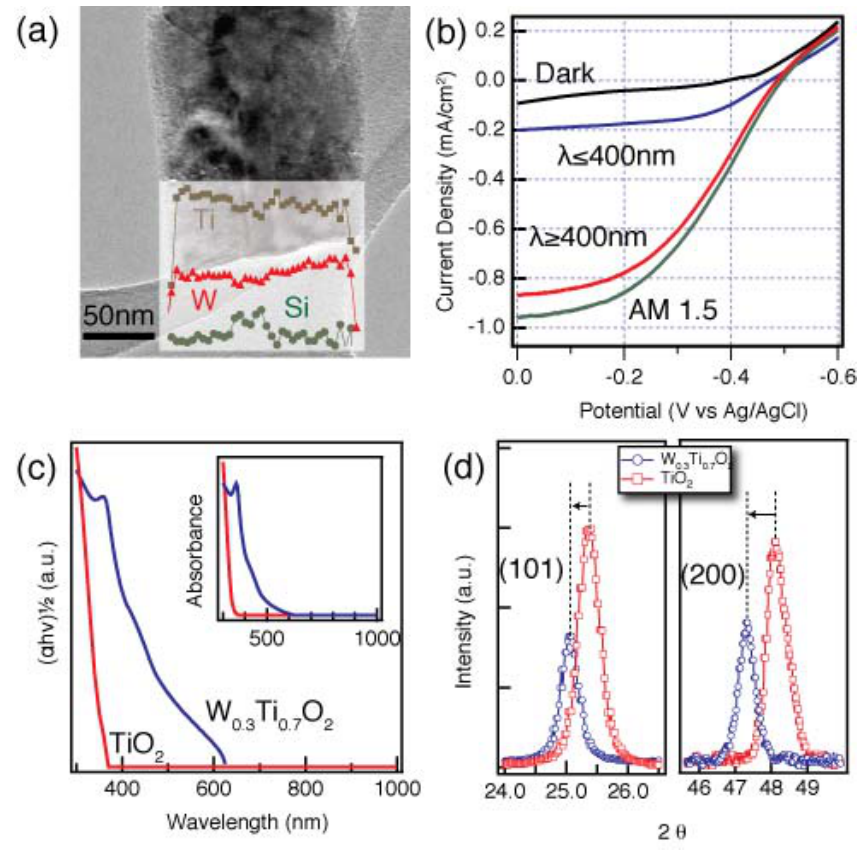
Figure 9. One chief advantage of the heterostructure design lies in the flexibility of the shell materials, which is explored here to enhance visible light absorption by doping TiO 2 with W [24]. (a) A TEM image of the W Ti O /TiSi heterostructure. Chemical analysis 0.3 0.7 2 2 shows uniform doping of tungsten into TiO shell. (b) Current-potential plots under 2 different illumination conditions proving photoactivity of the W-doped TiO in the visible 2 spectrum. (c) Absorption spectrum showing a reduced band gap of ~2.0 eV from 3.2 eV of pure TiO . (d) Peak shifts observed in the x-ray diffraction pattern indicate lattice 2 distortion induced by W dopant though the anatase structure is preserved. Reproduced with permissions from American Chemical Society